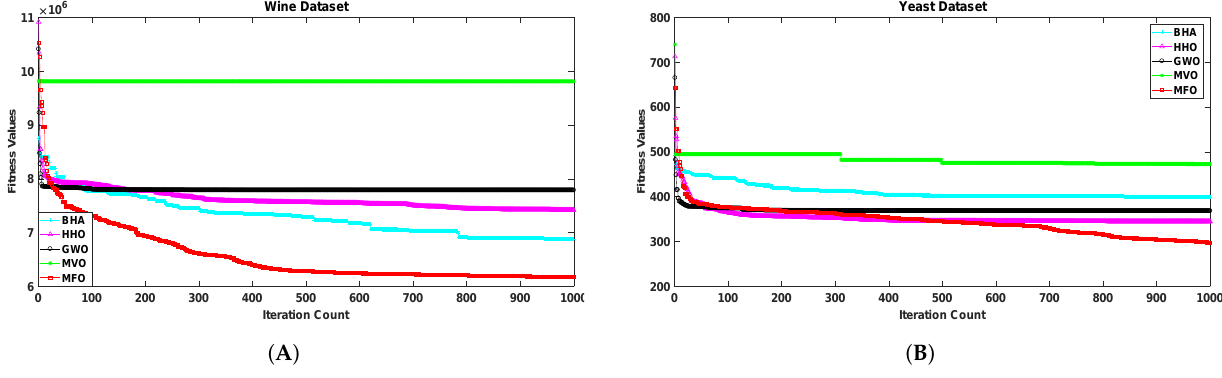
Figure 6. Variation in the best fitness values of algorithms for datasets ( A ): Wine, ( B ): Yeast with respect to